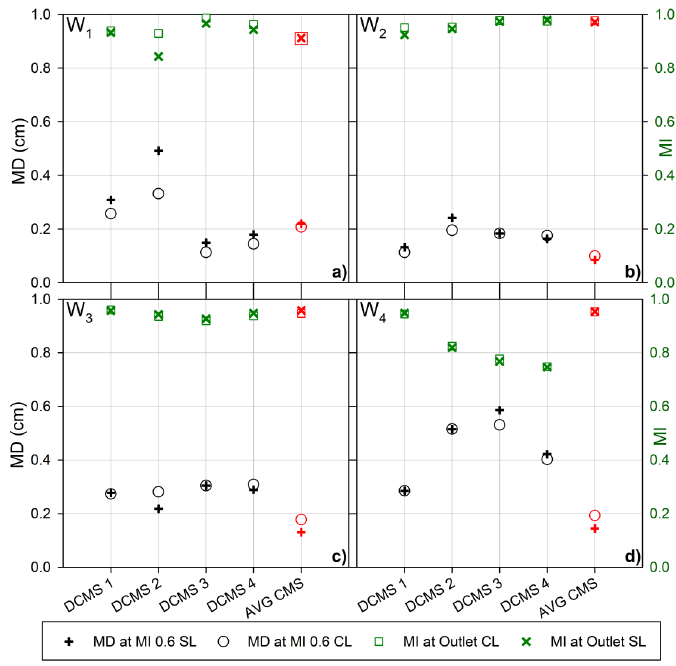
Figure 4. Mixing distance to achieve an MI of 0.6 (60%) (left Y-axis, black) for the channel layers (black ) and the sensor layer (black + ) and the mixing index at the outlet (right Y-axis, green) for the (cid:35) channel layers (green (cid:3) ) and the sensor layer (green × ) for the microfluidic channels with passive mixing structures, as indicated. The parameter values for the microfluidic channels with mixing structures with parameter design variables (Table 1) as prepared from ( a ) Wafer 1 (W 1 ), ( b ) Wafer 2 (W 2 ), ( c ) Wafer 3 (W 3 ) and ( d ) Wafer 4 (W 4 ), respectively. The average values for the previously reported curved mixing structure (AVG CMS) [56] is represented in